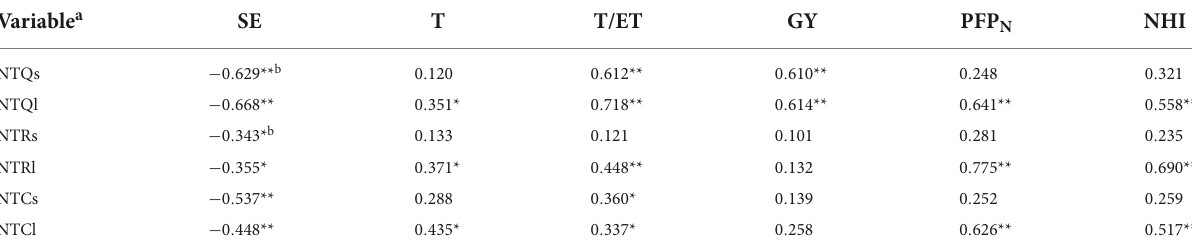
TABLE 6 Pearson’s correlation coefficients ( df = 36) of N translocation quantity (NTQ), ratio (NTR), and contribution (NTC) of stem and leaf relative to soil evaporation (SE), transpiration (T), ratio of transpiration to evapotranspiration (T/ET), grain yield (GY), N partial factor productivity (PFP N ) and N harvest index (NHI) of spring